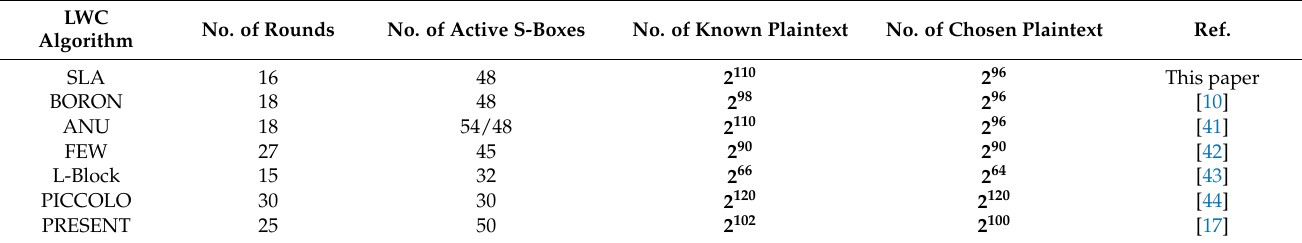
Table 7. Comparison of Linear and Differential